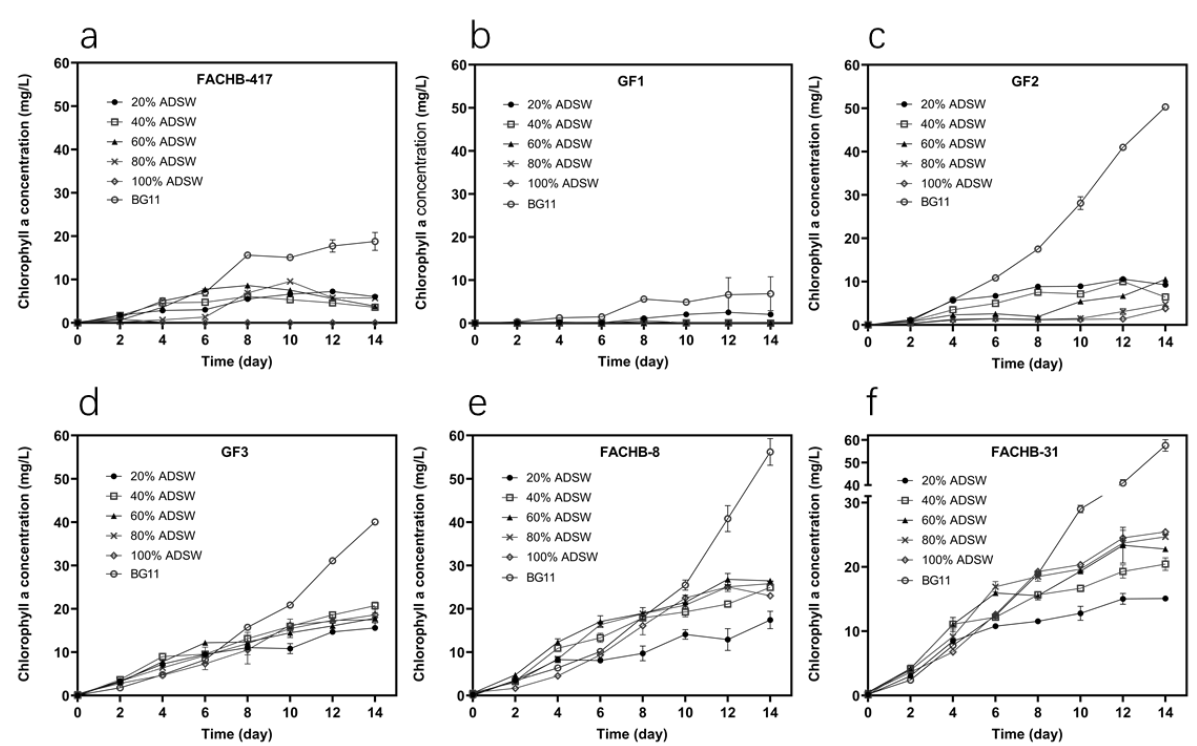
Figure 2. Time course of chlorophyll a concentration for six microalgal strains in five dilutions of ADSW and BG11 medium within 14 days. ( a ) S. obliquus FACHB-417, ( b ) C. zofingiensis GF1, ( c ) C. protothecoides GF2, ( d ) C. pyrenoidosa GF3, ( e ) C. vulgaris FACHB-8, and ( f ) Chlorella sp. FACHB-31. Error bars represent SD ( n = 3).